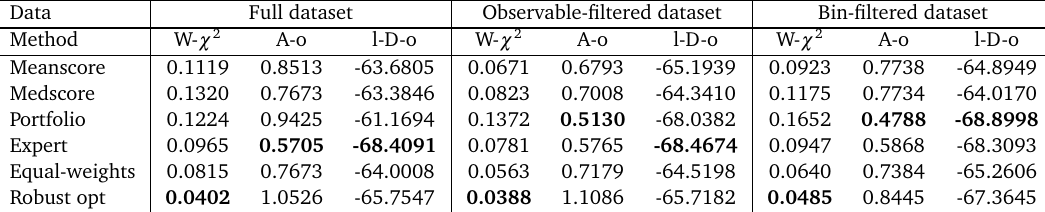
Table 5: A14 results with the full dataset , observable-filtered dataset and bin-filtered dataset when using the rational approximation. Lower numbers are better. The best results are in bold. In each dataset, W- χ 2 refers to the Weighted χ 2 metric, A-o refers to the A-opt metric, and l-D-o refers to the log D-opt